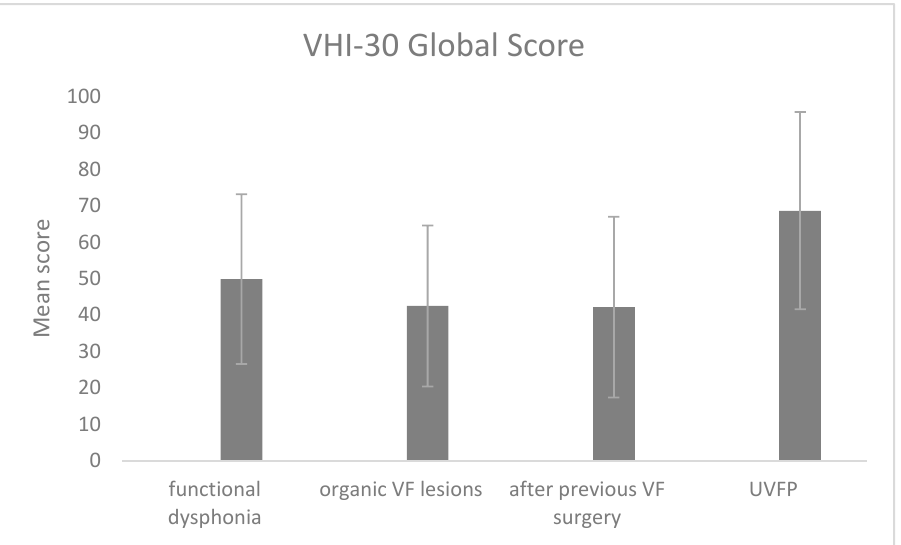
Figure 1. Mean VHI-POL global score depending on diagnosis. The error bars represent standard deviations. VF, vocal fold; UVFP, unilateral vocal fold paralysis.